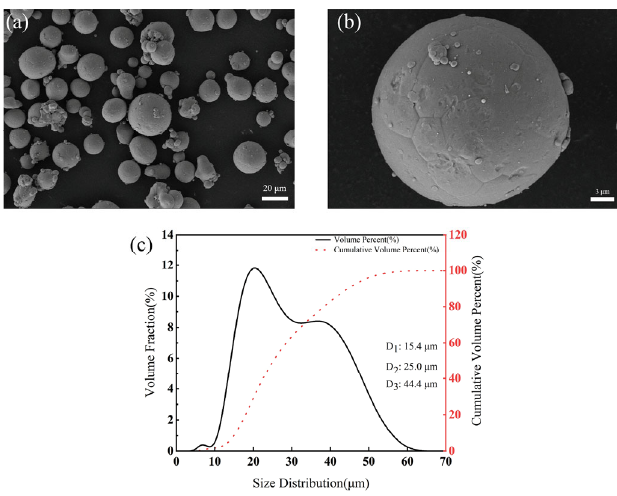
Figure 1. ( a ) 500× SEM, ( b ) 2000× SEM, and ( c ) particle size distribution of the Al